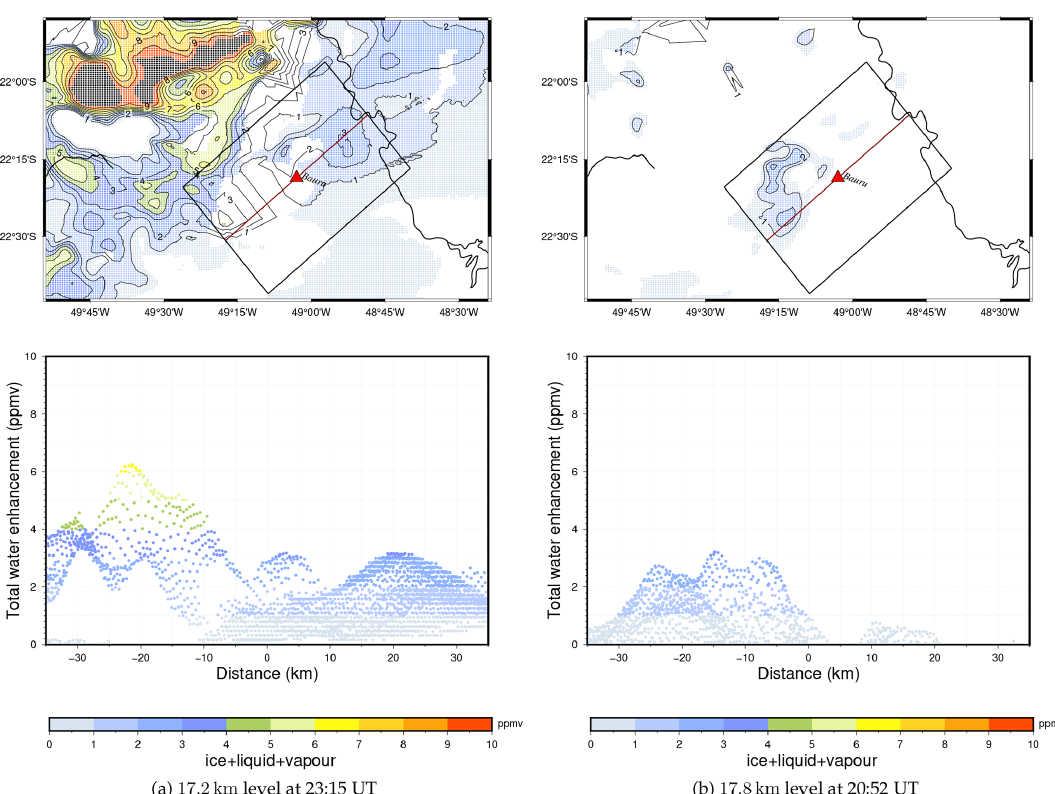
Figure 3. REF providing total water (ice, liquid, and vapour) enhancement at (a) 17.2km altitude at 23:15UT and (b) 17.8km altitude at 20:52UT, respectively. The top panel shows the horizontal cross sections of the vertical grid at these altitudes, depicting the only grid points when their total water content is higher than the model levels simply above and below in a vertical column. The isolines show the enhanced total water content (ppmv) with respect to the model layer below it. The bottom panel shows the grid points’/pixels’ water content confined by the northeast-tilting rectangle having the length of 70km and half width of 25km. The red triangle denotes Bauru (0km); the northeast direction is positive, and vice